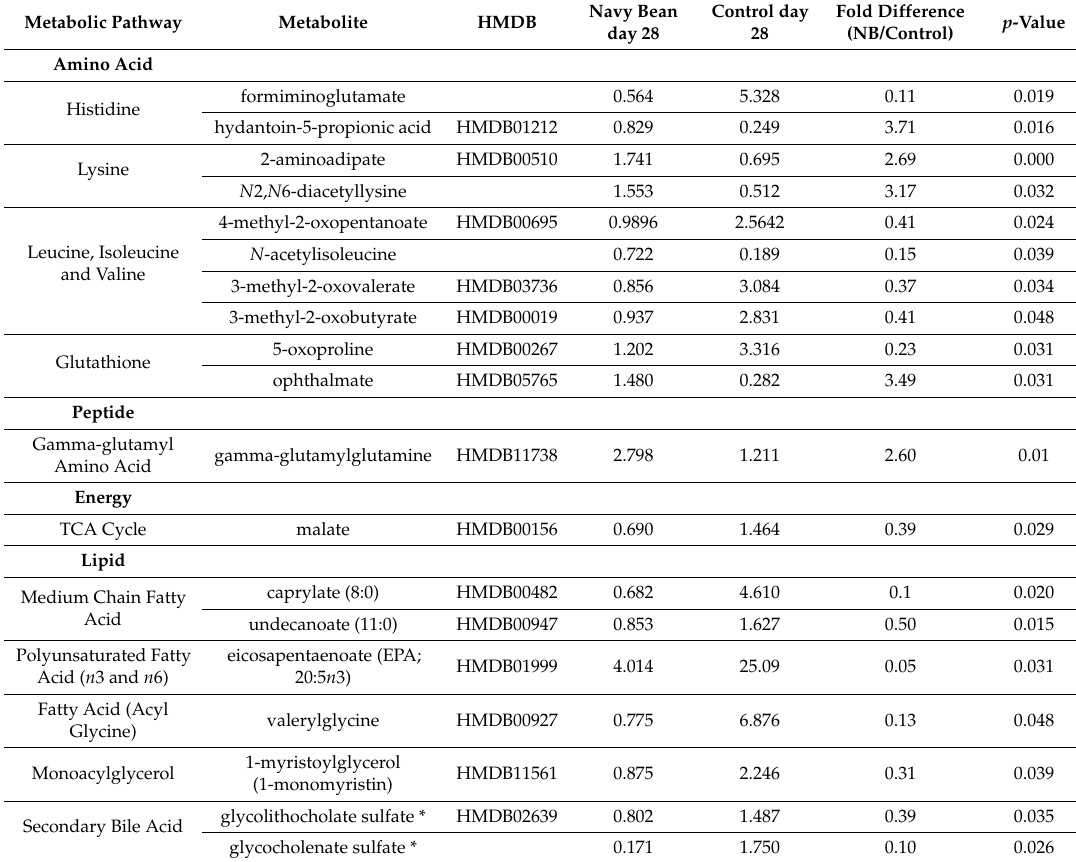
Table 3. Stool metabolites with statistically significant fold differences in abundance were identified between groups at day 28 following completion of the navy beans or control dietary